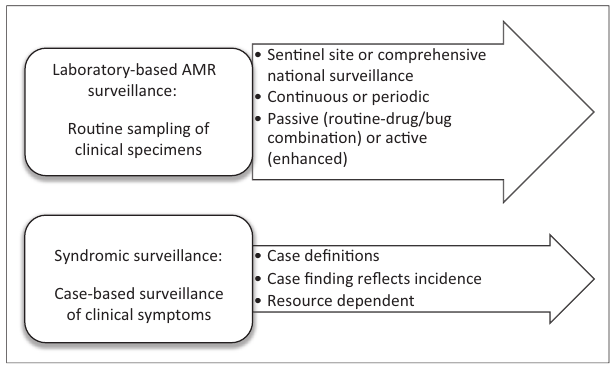
FIGURE 3: Surveillance